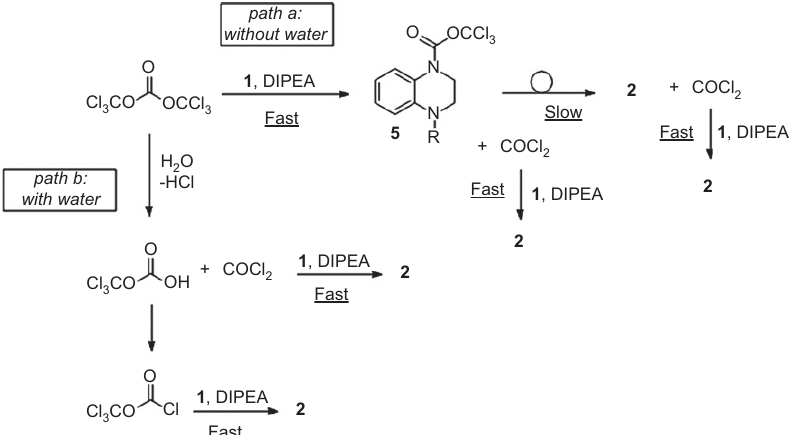
Figure 2 Proposed mechanism for the addition of 1 on BTC in presence of diisopropylethylamine (DIPEA) (path a). Proposed mechanism underlining the role of water in the reaction (path b).